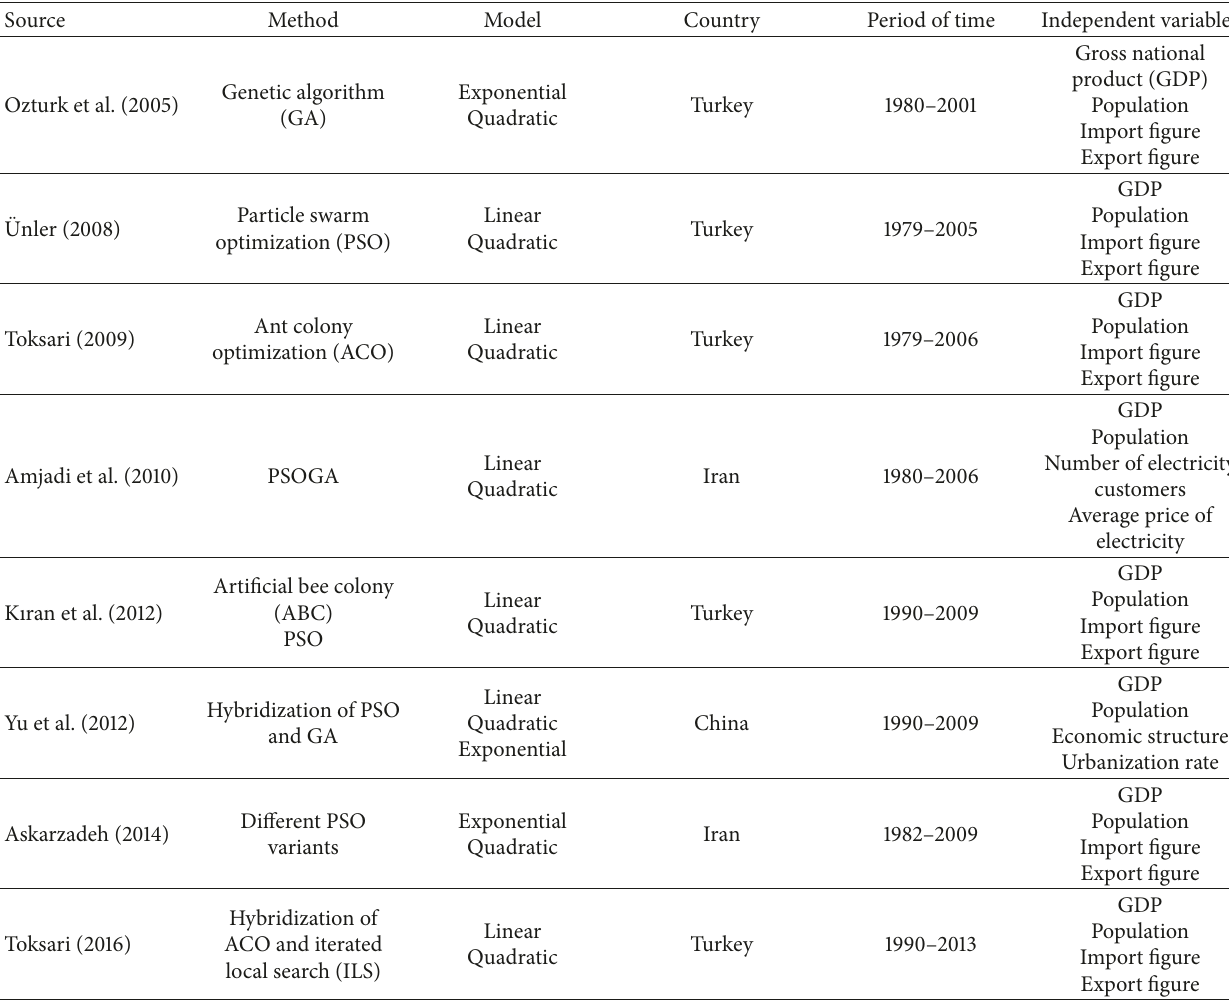
Table 1: A brief review of previous